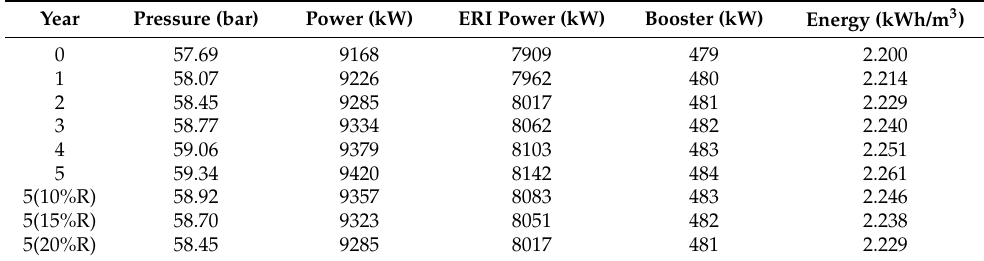
Table 12. Pressure, Power, and Energy consumption at 27 ◦